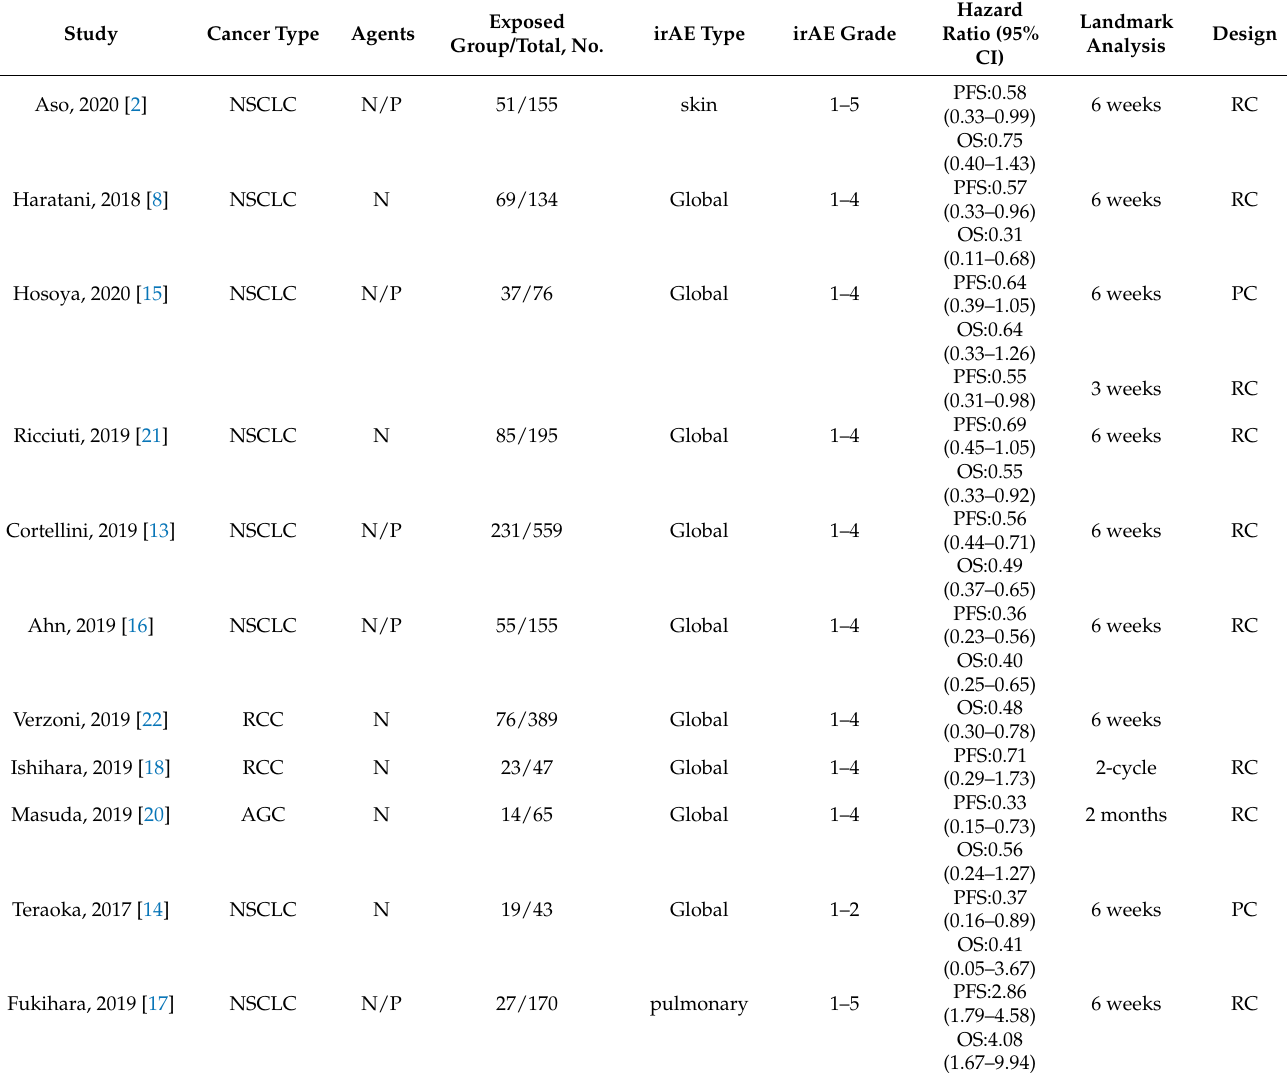
Table 1. Main characteristics of the eligible